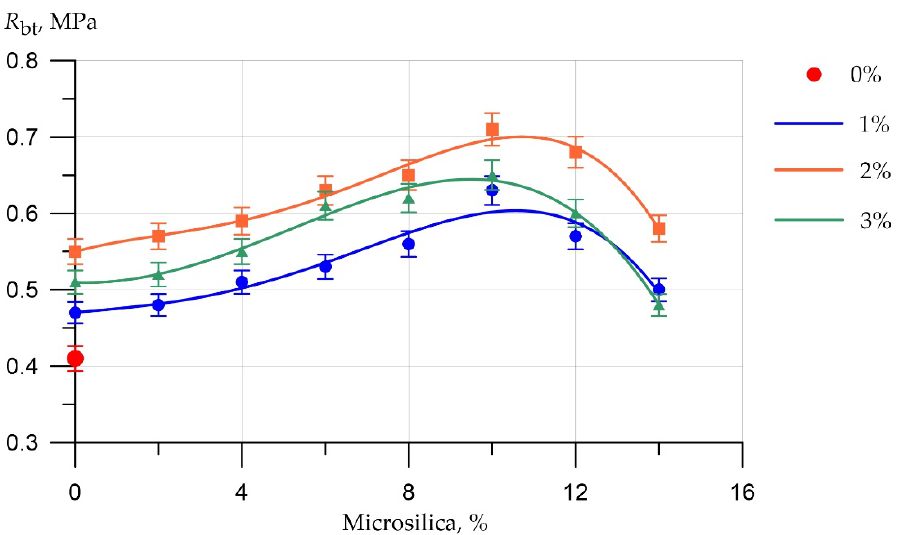
Figure 10. Results of experimental studies of tensile strength in bending of fiber foam concrete samples at various dosages of microsilica introduced instead of a part of the binder and dosages of polypropylene fiber of 0%, 1%, 2%, 3%.